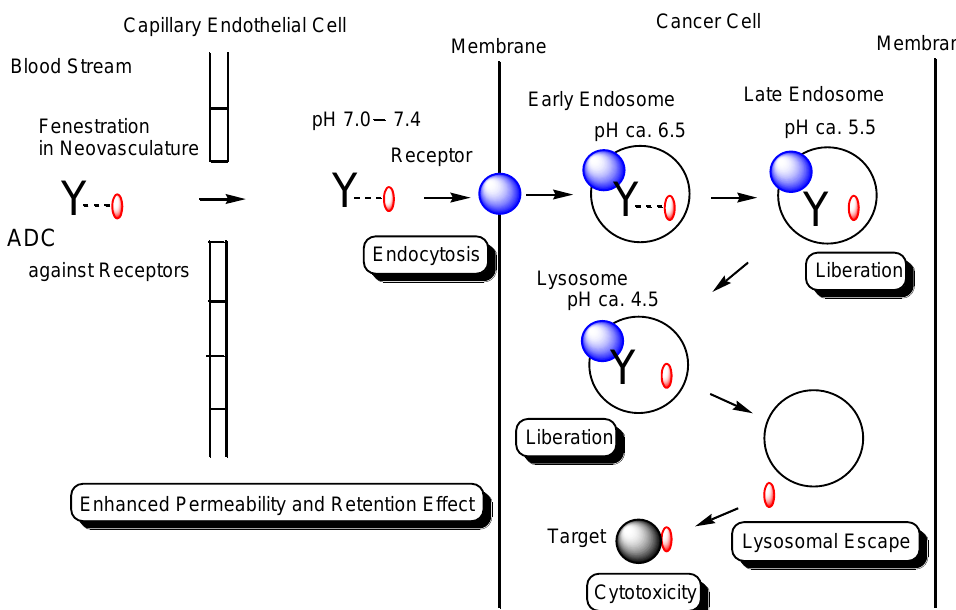
Figure 2. The pathway of intravenously administered antibody–drug conjugates (ADCs) against receptors such as cancer antigens. ADCs were internalized into cancer cells via receptor-mediated endocytosis (RME). Payloads were liberated by pH-sensitive linker cleavage based on acidification as endosome maturation or by enzymatically cleavable linker cleavage based on lysosomal enzymes and were transported to the cytoplasm by endosomal or lysosomal escape via passive diffusion and/or carrier-mediated transporters. Finally, payloads exhibited anti-cancer activity in the cytoplasm or the nucleus. Y represents a monoclonal antibody (mAb). The blue sphere indicates a receptor that mediates endocytosis in cancer cells. The red ovals represent a drug that is tethered with a mAb through a suitable linker. The black sphere indicates target substances such as topoisomerase II or DNA. The dotted line indicates a linker contained in an ADC. The solid line represents the membrane.